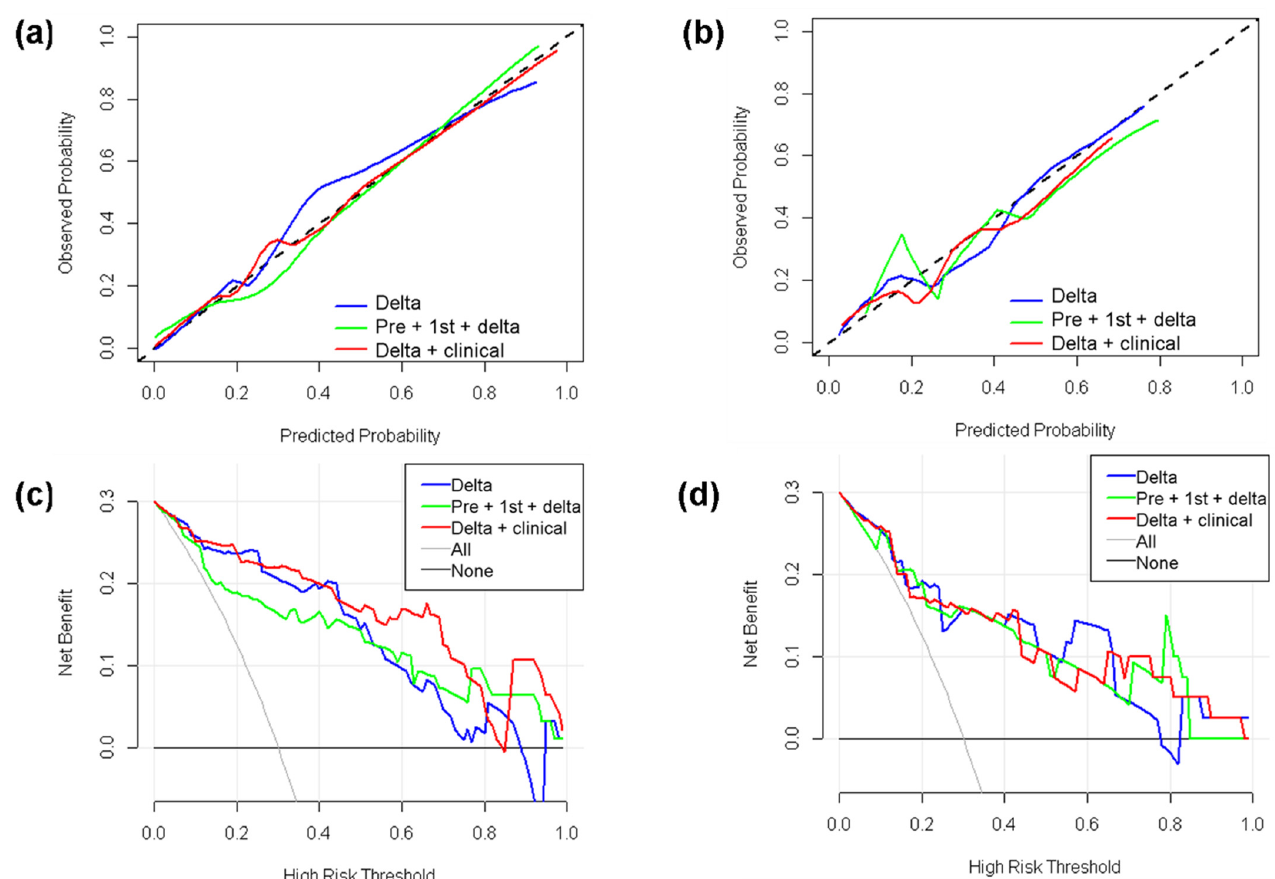
Figure 5. Calibration curves and decision curve analysis (DCA) for the optimal delta-radiomics model, longitudinal fusion-radiomics model, and clinical-radiomics model. ( a ) Calibration curves for the training cohort. ( b ) Calibration curves for the validation cohort. The dotted line represents a perfect classification. ( c ) DCA results for the training cohort. ( d ) DCA results for the validation cohort. The y -axis represents the net benefit. The solid gray line represents the scenario that all patients were included in the pCR group. The solid black line represents the scenario that no patients were included in the pCR group. The x -axis represents the threshold probability (i.e., where the expected benefit of the treatment is equal to the expected benefit of avoiding treatment).